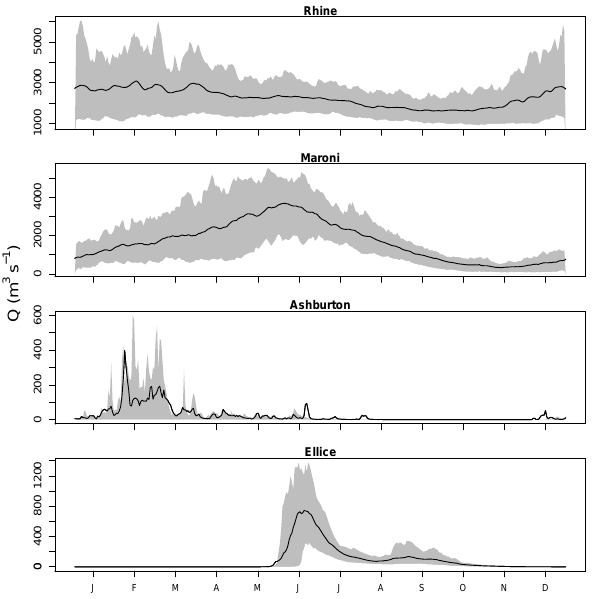
Fig. 2. Yearly regimes of the four selected rivers based on average daily discharge (black line) and the spread between the 10th and 90th percentile values (gray